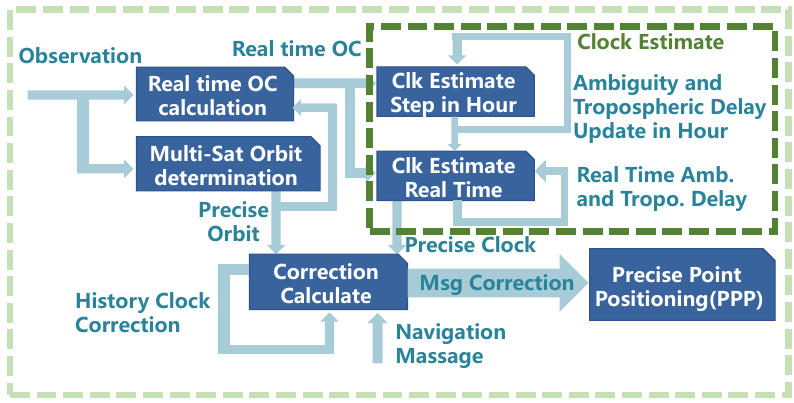
Figure 1. Estimation Process of PPP-B2b Clock Offset